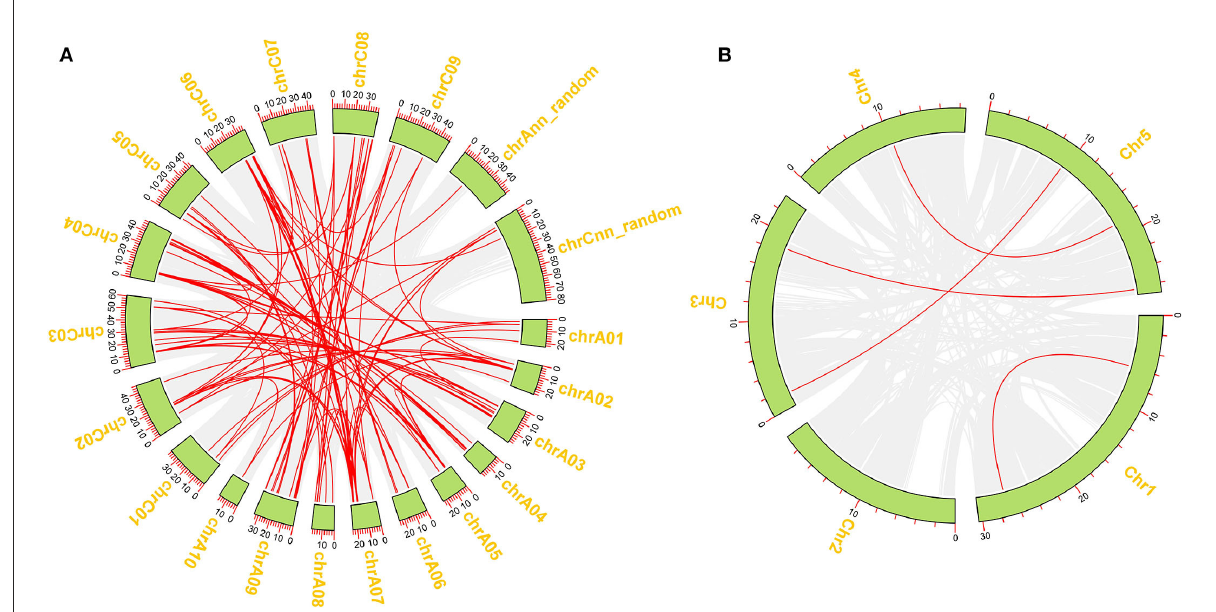
FIGURE3 Duplication of BnRLP and AtRLP genes. (A) Duplication of RLP genes in Brassica napus . (B) Duplication of RLP genes in Arabidopsis thaliana . The red line represents the gene pairs and the green box represents the genome.